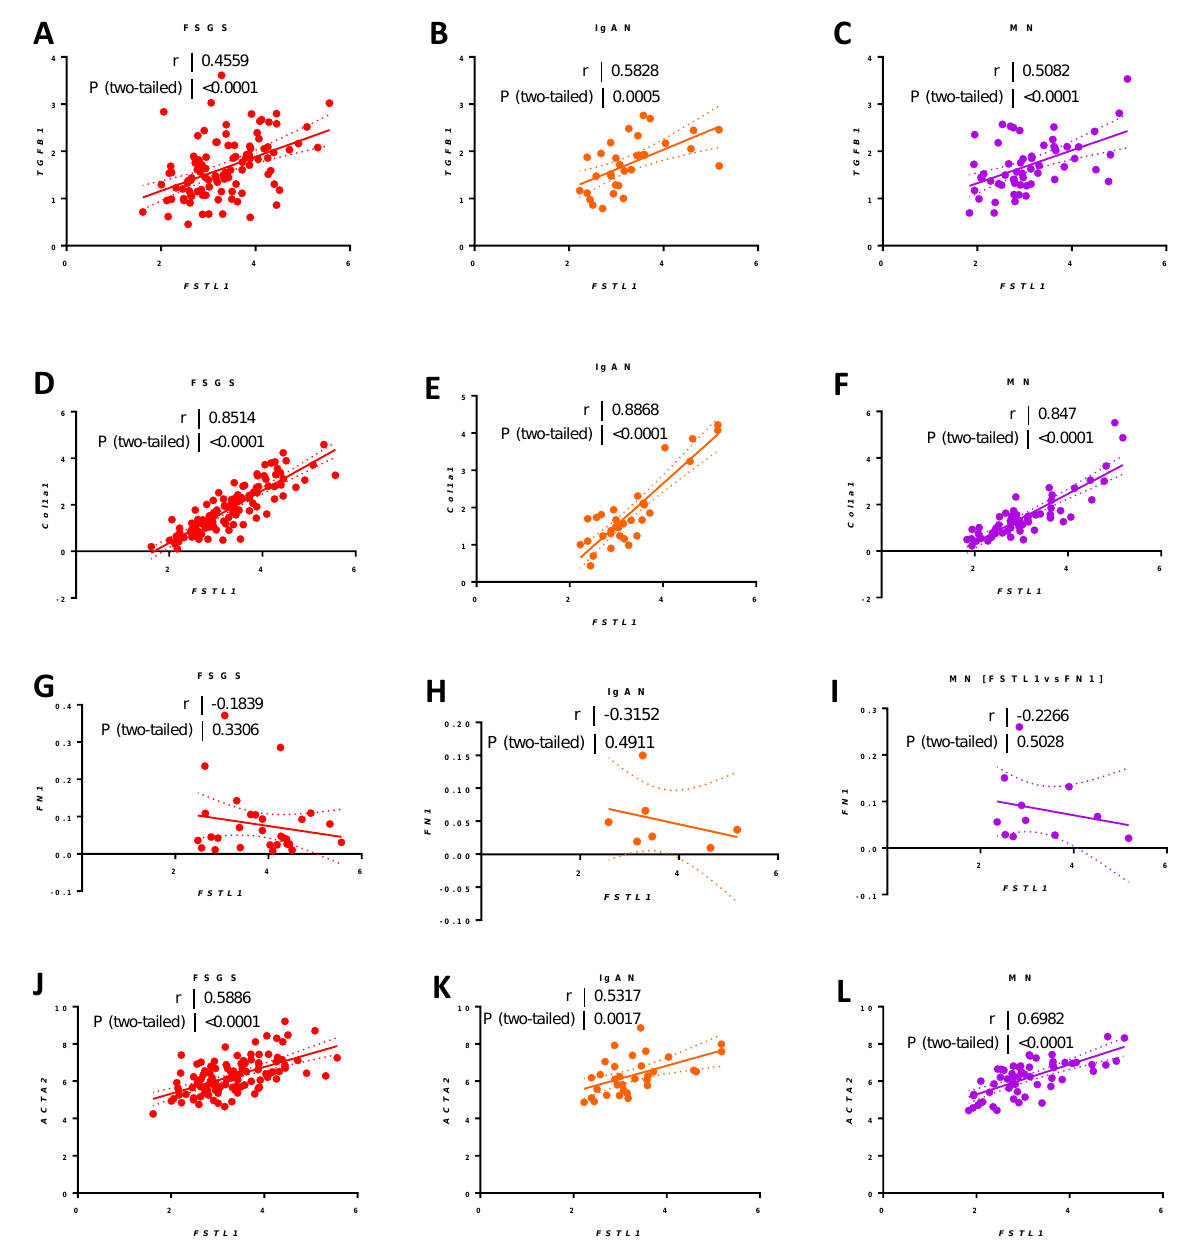
Figure 24. Relationship of FSTL1 mRNA Levels to the Expression of Genes Implicated in Fibrosis in FSGS (red), IgAN (orange), and MN (purple). Table 1. expression correlated to FSTL1 mRNA levels in FSGS ( A ), in IgAN ( B ), and MN ( C ). COL1A1 expression correlated to FSTL1 mRNA levels in FSGS ( D ), in IgAN ( E ), and in MN ( F ). FN1 expression correlated to FSTL1 mRNA levels in FSGS ( G ), in IgAN ( H ), and MN ( I ). ACTA2 expression correlated to FSTL1 mRNA levels in FSGS ( J ), in IgAN ( K ), and MN ( L ). Pearson’s correlation coefficient ( r ) was determined, and two-tailed p values derived. Significance was determined as a p value of <0.05. Linear regression generated the line of best fit (solid lines) with 95% confidence intervals (dotted lines).